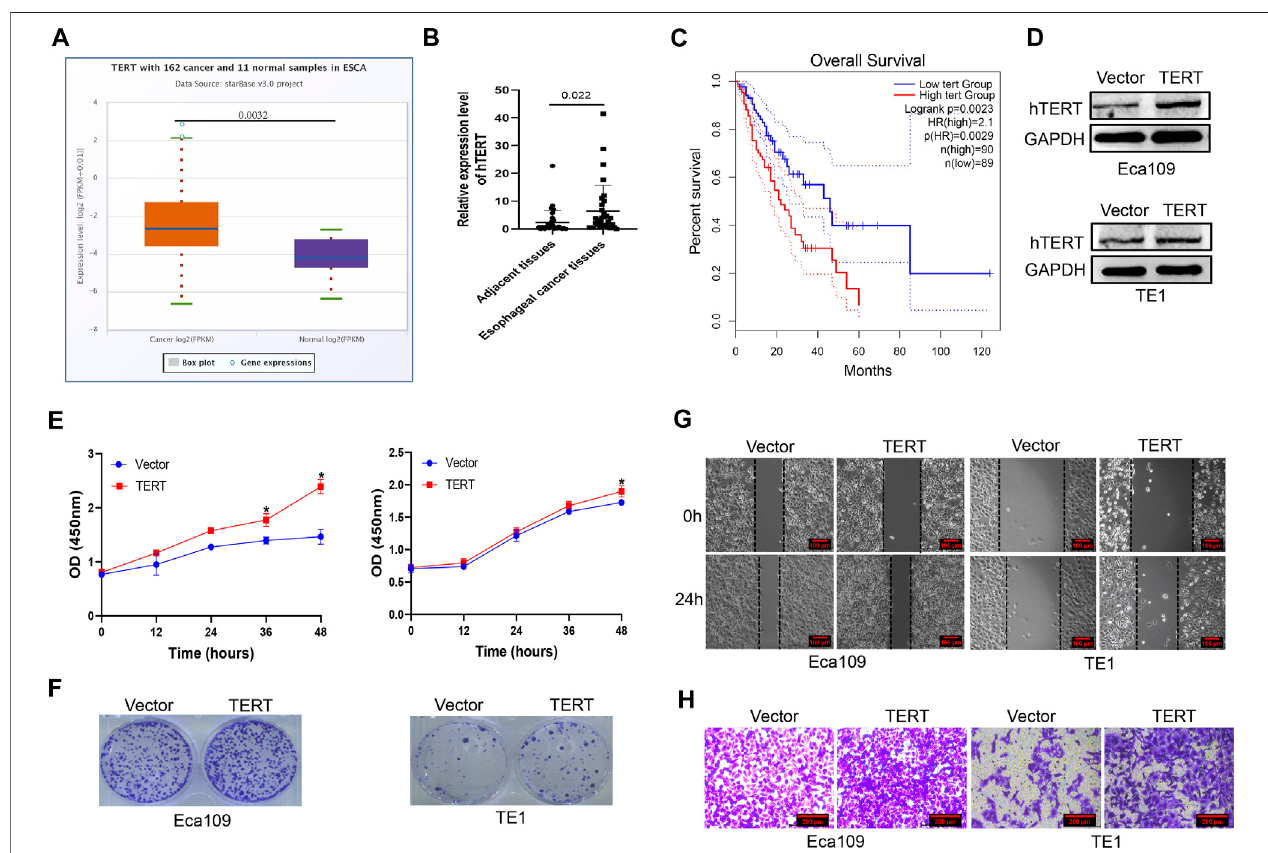
FIGURE1| Highexpression ofhTERT promotes theproliferationand metastasis ofesophagealcancer. (A) Theexpression ofhTERTmRNAinesophageal cancer from TCGA database. (B) The expression of hTERT mRNA in ESCC tissues and adjacent tissues (32 paired). (C) The correlation of hTERT with prognosis of ESCC patients from TCGA database. (D) The overexpression ef fi ciency of pcDNA3.1 – 3 × HA-TERT plasmids in Eca109 and TE1 cells. (E) CCK-8 assay and (F) plate colony formation assay were employed to determine overexpression of hTERT on the proliferation of esophageal cancer. (G) Scratch assay and (H) transwell assay were employed to determine overexpression of hTERT on the migration of esophageal cancer. (* indicate p < 0.05 compared with control).